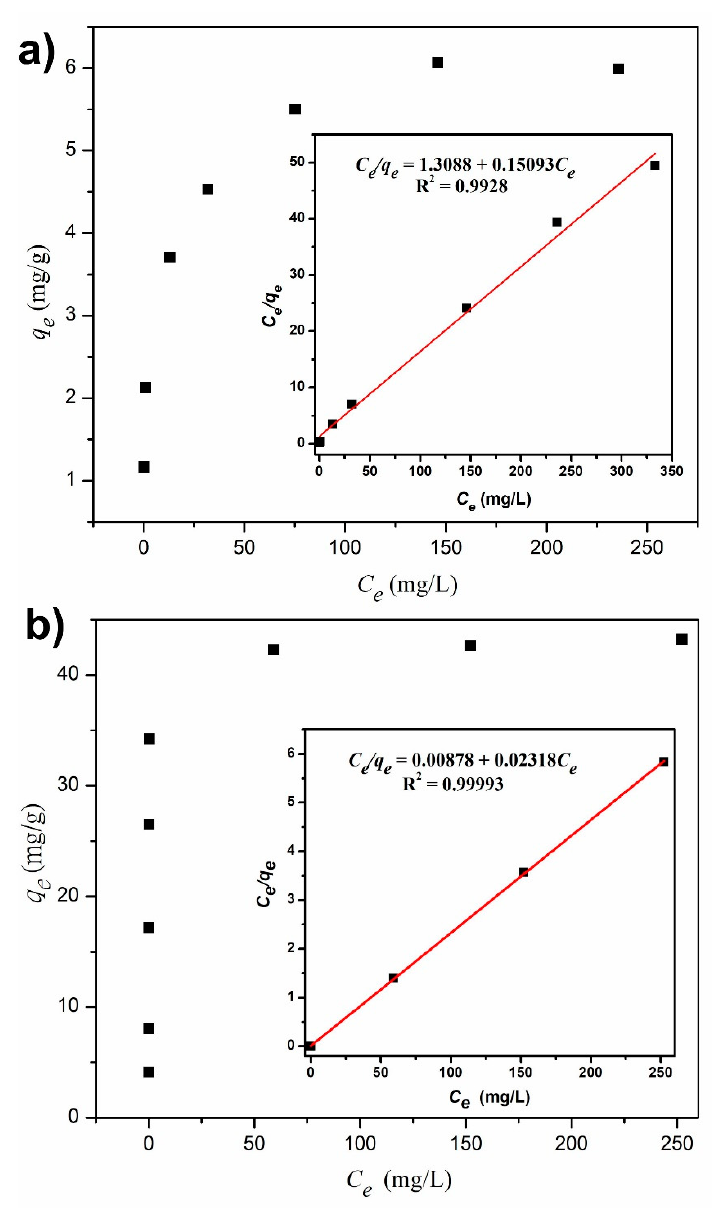
Figure 10. Adsorption isotherm of ( a ) cellulose without treatment, and ( b ) cellulose treated with succinic anhydride (Com-1). Inserts show the experimental data fitted to the isothermal Langmuir model.